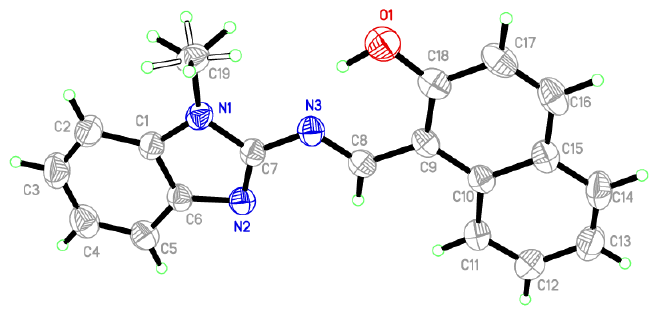
Figure 2. Ortep view of the single X-ray structure of the ligand at the 50% probability level. Table 1. Crystal data of the ligand “ bimnap ” .